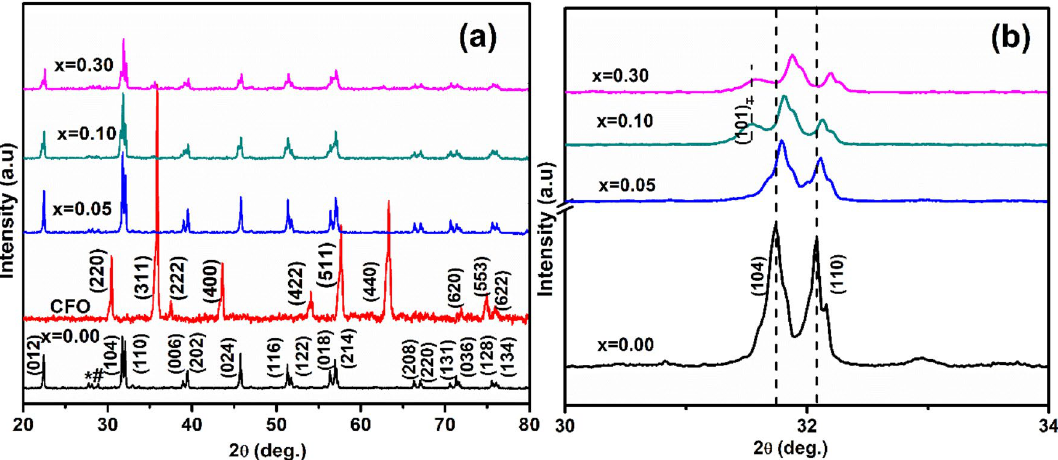
Figure 1. (a) X-ray diffraction patterns of (1 − x) BFO–xCFO (CFO, x = 0.00, 0.05, 0.10 and 0.30) ceramic powders calcined at 840 °C for 3 h (*Bi 24 Fe 2 O 39, #Bi 2 Fe 4 O 9 ). (b) Expanded XRD patterns range between 2θ = 30°–34° and showing corresponding to tetragonal (101) T and rhombohedral (104)/(110)